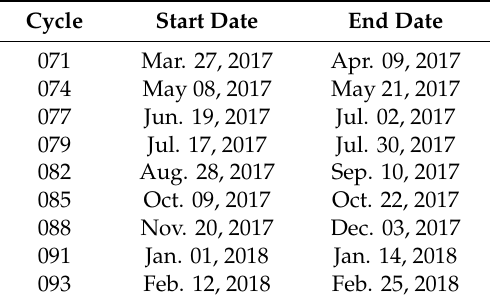
Table 2. Acquisition dates for the PALSAR-2-based reference inundation classification maps. Cycle Start